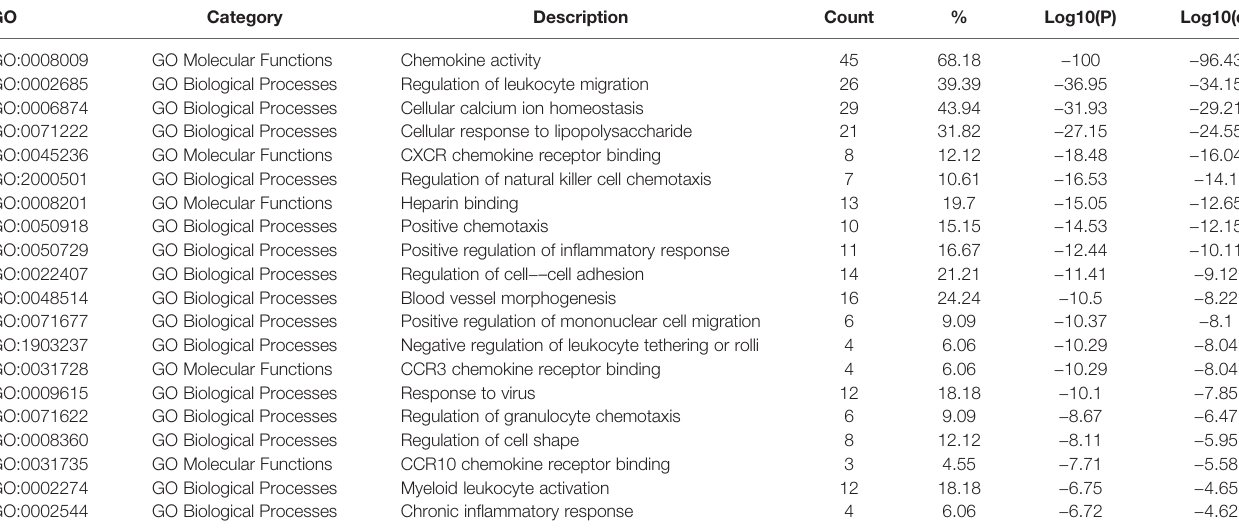
TABLE 2 | The GO function enrichment analysis of CXC-chemokines and neighbor genes in HNSCC (Metascape).